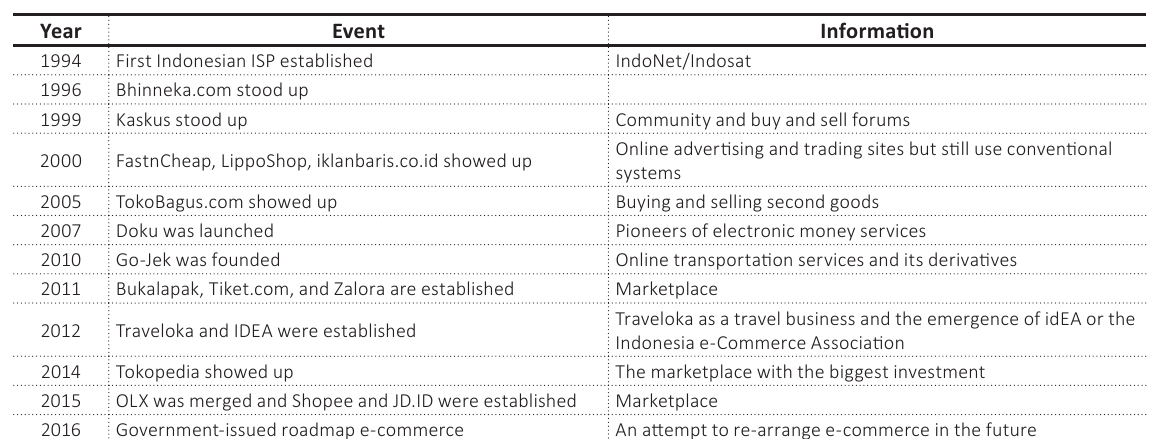
Table 1. The evolution of e-commerce business in